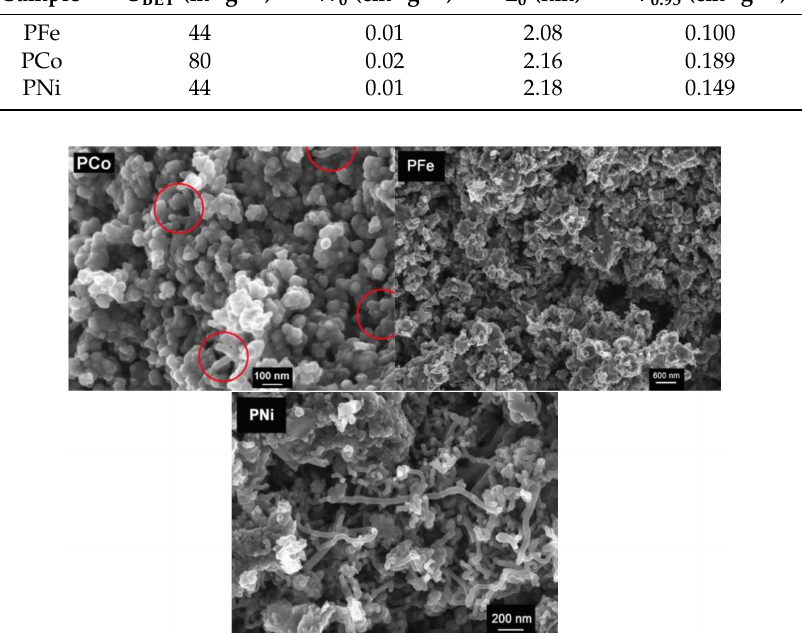
Figure 1. SEM microphotographs showing the morphology of the different composites. Red circles indicate CNF in sample PCo.